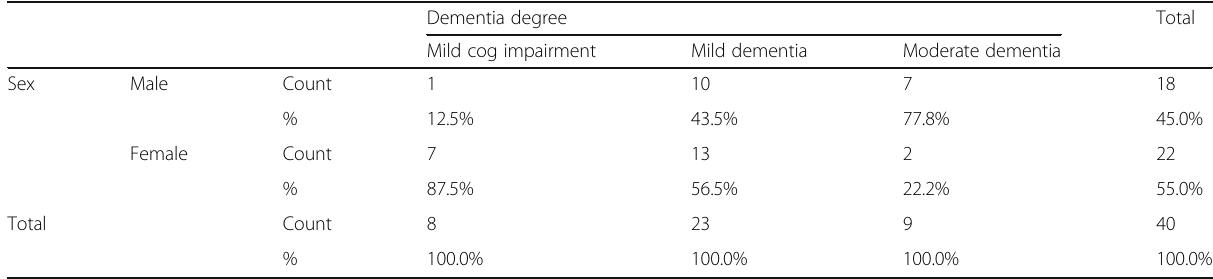
Table 10 Distribution of the degree of dementia according to sex